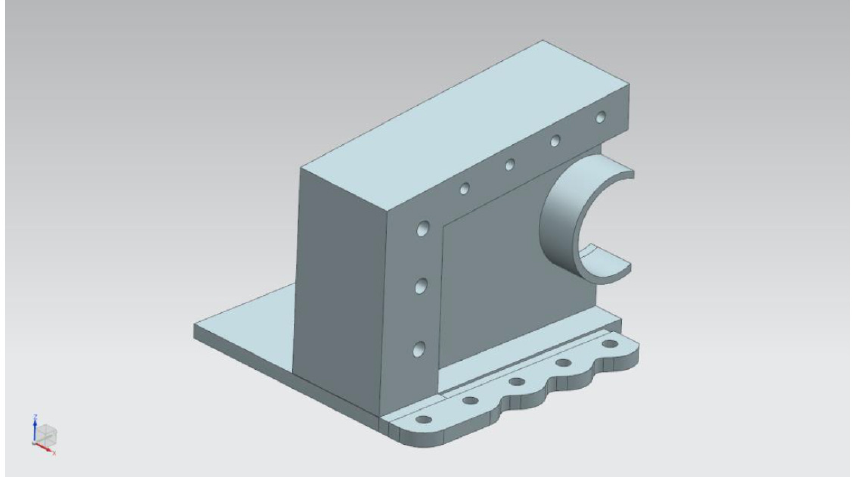
Figure 6. Redrawn wing root for crack growth analysis.